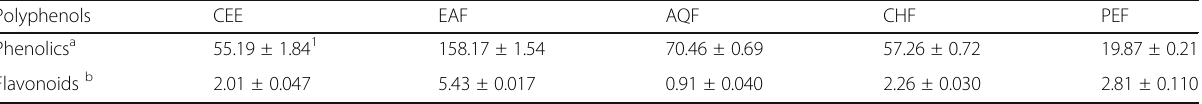
Table 1 Polyphenol contents of CEE and its various fractions: EAF, AQF, CHF and PEF Polyphenols CEE EAF